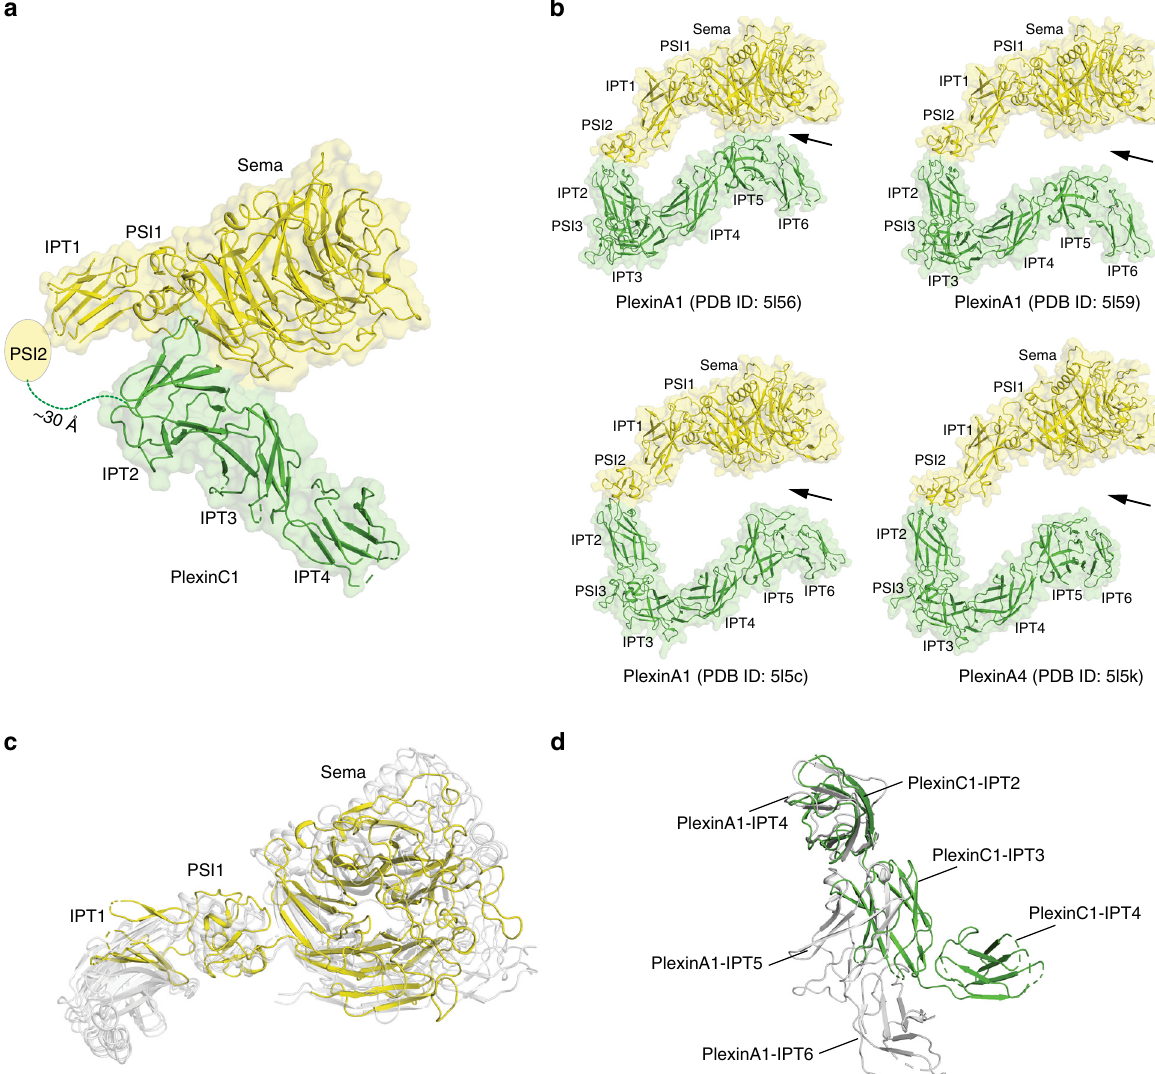
Fig. 2 Comparison of the ectodomain structures of PlexinC1 with class A plexins. a Overall structure of the PlexinC1 extracellular region. The Sema, PSI1, IPT1, and PSI2 together form the fi rst rod (yellow). The IPT2 – 4 domains form the second rod (green) that is arranged in a roughly orthogonal orientation relative to the fi rst rod. b Crystal structures of PlexinA1 and PlexinA4. The ring-shaped architecture show substantial variations among these structures, leading to large differences in the distance between the Sema and membrane-proximal domains (highlighted by arrowheads). c Superimposition of the Sema – PSI1 – IPT1 domains of PlexinC1 (yellow) and class A plexins (gray). The superimposition is based on the Sema domain. d Superimposition of the three membrane-proximal IPT domains of PlexinC1 (IPT2 – 4) and PlexinA1 (IPT4 – 6) (PDB ID: 5l56). The superimposition is based on the N-terminal IPT